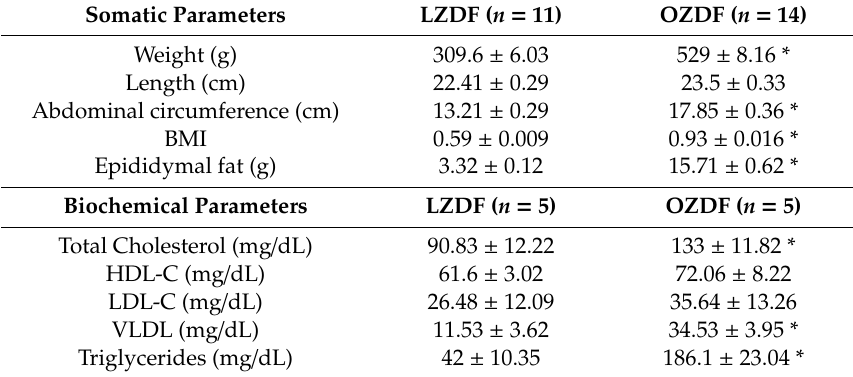
Table 1. Somatic and biochemical parameters of ZDF rats. The values represent the mean ± SE (standard error). Data were compared using Student’s t -test with a minimum significance value of 0.05 ( p value). The * represent the significant di ff erences observed when compare the OZDF vs LZDF group. Analysis of somatic parameters was performed with a n of 11 rats for the LZDF group and 14 rats for the OZDF group. For the biochemical analysis, 5 rats of each group were used. BMI (body mass index), HDL-C (high-density lipoprotein cholesterol), LDL-C (low-density lipoprotein cholesterol), VLDL (very low-density